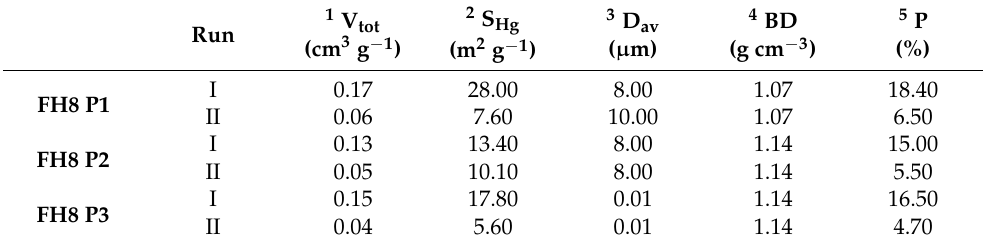
Table 4. MIP measurements of irbesartan